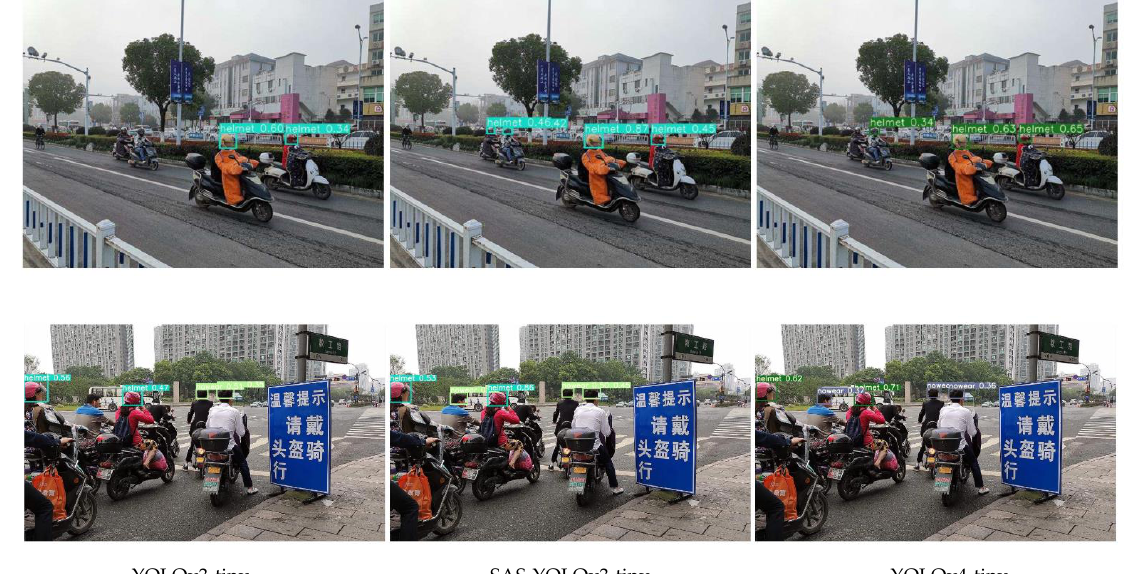
Figure 7. The detection results of some test images.